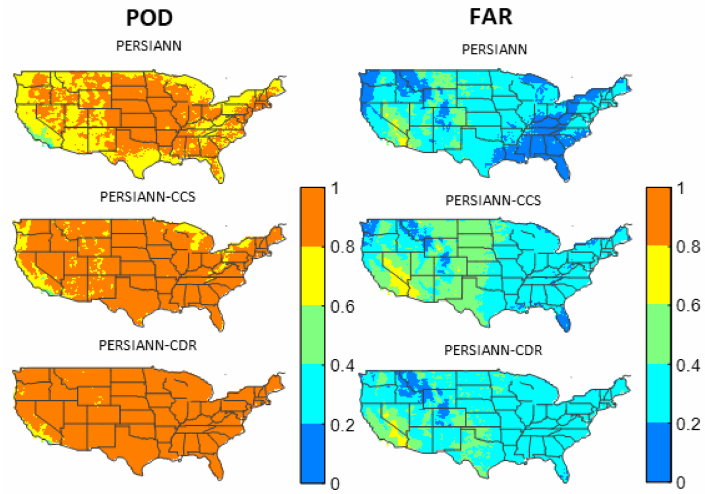
Figure 3. Probability of detection (POD) and false alarm ratio (FAR) of PERSIANN, PERSIANN-CCS, and PERSIANN-CDR against CPC for the period (2003–2015) over the CONUS.